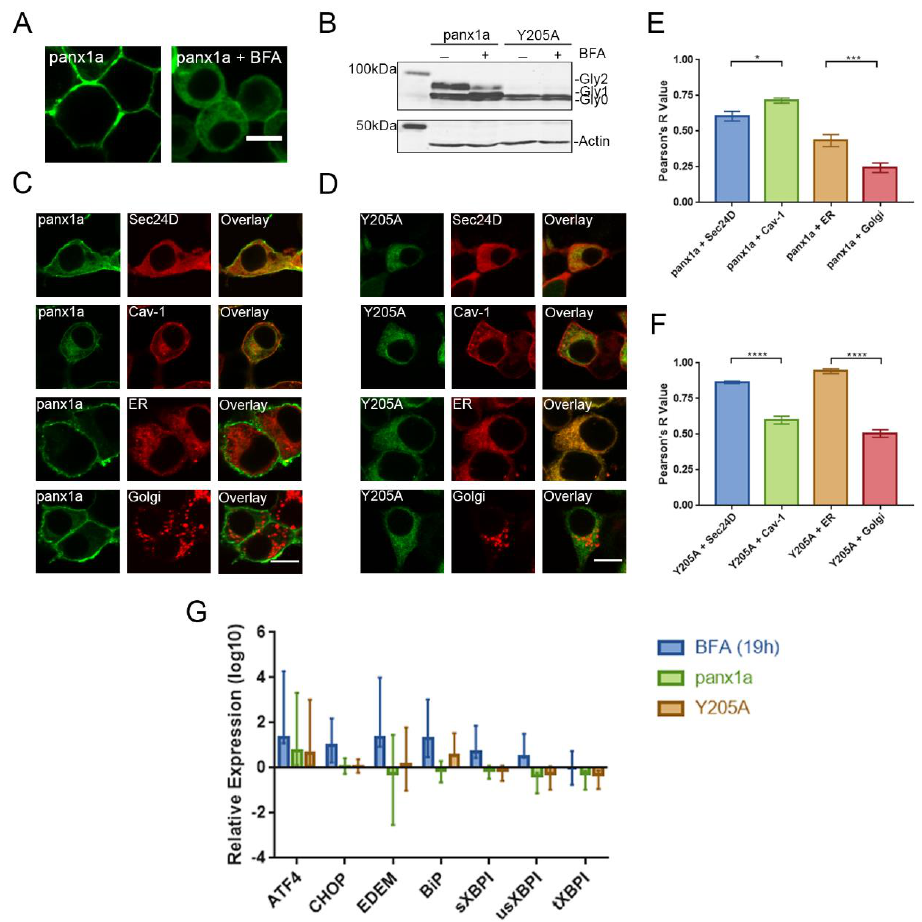
Figure 4. Expression of Brefeldin A (BFA)-treated cells, co-localization with cellular markers, and ER stress analysis of panx1a and the Y205A mutant. ( A ) Images of panx1a-EYFP transfected Neuro 2a cells treated with 5ug / mL BFA for 19h showed a reduction of cell membrane localization. Scale bar: 10 µ m. ( B ) Western blot analysis showed that treatment with 5ug / mL BFA for 19h caused a decrease in the Gly2 state and an increase in the Gly1 state of the wild type panx1a protein. No e ff ect was detected for the Y205A mutant. Proteins were detected using an anti-GFP antibody. ß-actin served as a protein loading control. ( C , D ) Co-localization of EYFP-tagged panx1a and the Y205A mutant with mCherry-tagged Sec24D (COP II vesicle marker), His-tagged Cav-1 (Caveolin-1 marker), DsRed-tagged calreticulin (ER marker), and DsRed-tagged galactosyltransferases (Golgi apparatus marker). His-tagged Cav-1 was detected using an anti-His antibody and Alexa Fluor 568 secondary antibody. ( E , F ) Co-localization quantification of the wild type and mutant panx1a with the vesicle and organelle markers. Error bars show standard error of the mean. WT panx1a + Sec24D: n = 34, WT panx1a + Cav-1: n = 36, WT panx1a + ER: n = 29, WT panx1a + Golgi: n = 35, Y205A + Sec24D: n = 30, Y205A + Cav-1: n = 31, Y205A + ER: n = 20, Y205A + Golgi: n = 20. ( G ) Real-time qPCR analysis of ER stress genes. Neuro 2a cells were transfected with EYFP alone, panx1a-EYFP, and Y205A-EYFP. When indicated, cells were treated with 5ug / mL BFA for 19h. 18s rRNA was used as the reference gene. EYFP-transfected cells were used as the control group. Data were collected in three independent experiments in triplicate for each gene. All data were relative to the EYFP control group. **** p < 0.0001, *** p < 0.001, * p < 0.05. To test whether Y205A is retained in the intracellular compartments, co-localization studies with organelle and vesicle biomarkers were performed. Neuro 2a cells were double